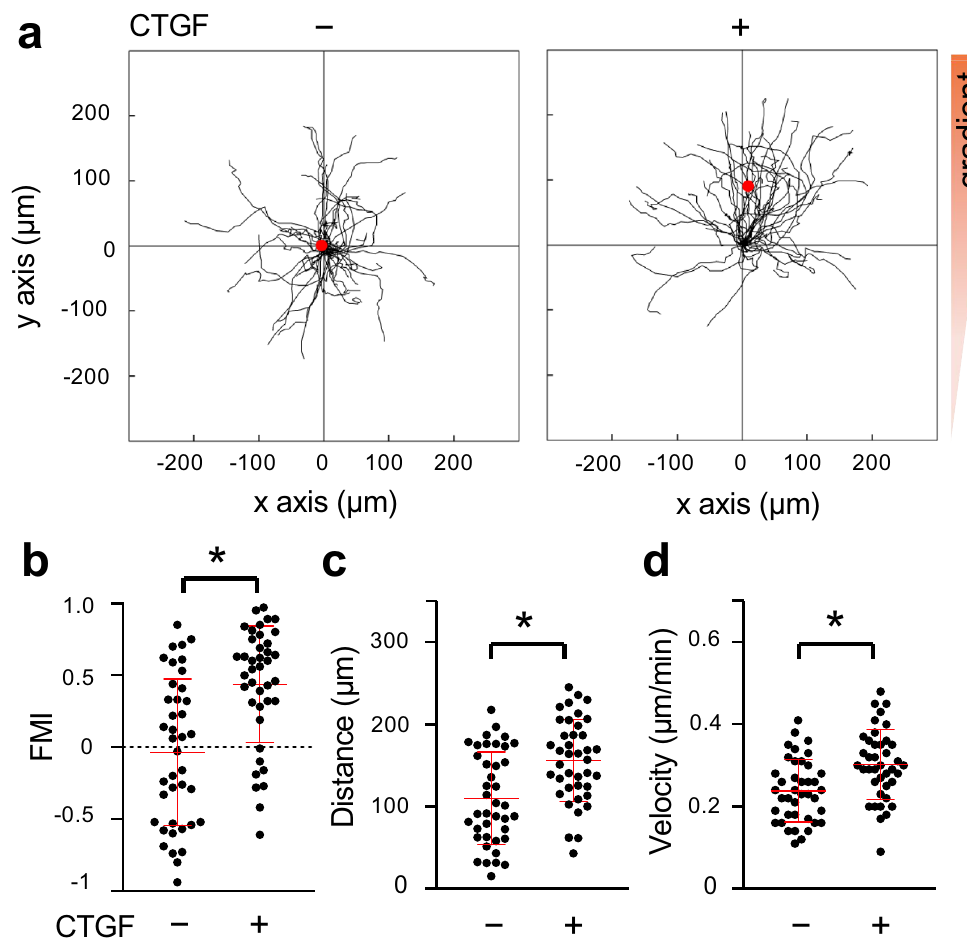
Figure 4. CTGF gradient induced chemotaxis of preosteoblastic MC3T3-E1 cells. ( a ) MC3T3-E1 cells were seeded onto an observation area between two reservoirs in a μ-slide chemotaxis chamber and cultured overnight. Then 150 ng/ml CTGF was added to one reservoir and the cells were allowed to migrate toward CTGF for 12 h. The migration paths of 40 individual cells were analyzed. The red dot represents the center of mass of the endpoints of tracked cells. The parameters FMI ( b ), distance ( c ), and velocity ( d ) were determined (n = 40). *p < 0.05, Mann–Whitney U